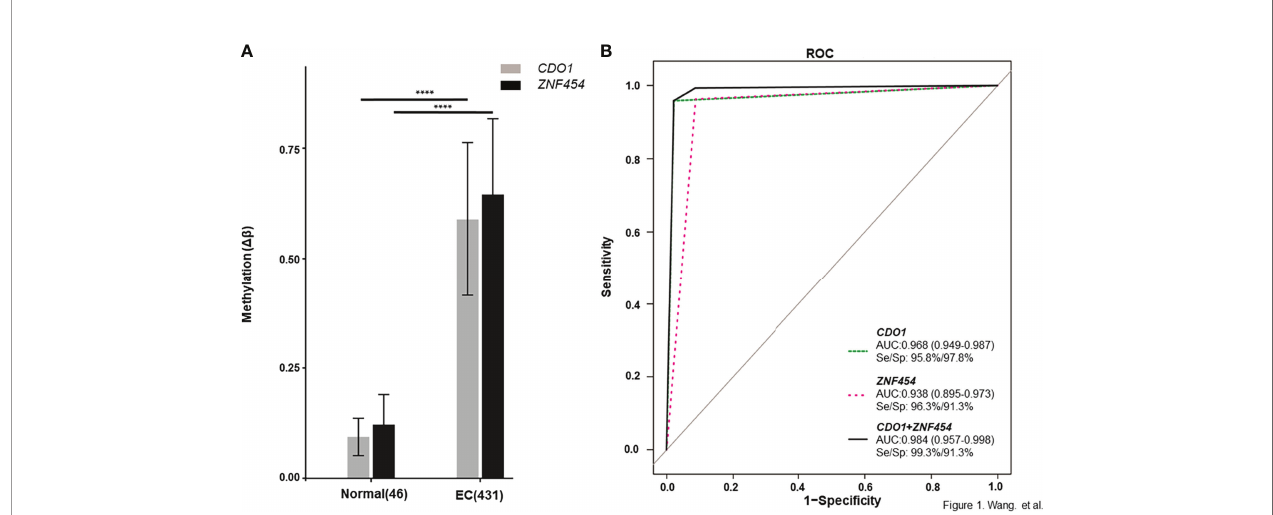
FIGURE 1 | DNA methylation levels of candidate genes from TCGA database. DNA methylation levels are displayed as Db -values for each candidate gene. (A) CDO1 and ZNF454 methylation levels between cancerous and normal tissues. (B) The area under the receiver operating characteristic curve (AUC-ROC) for the DNA methylation status of CDO1 and ZNF454. **** P <